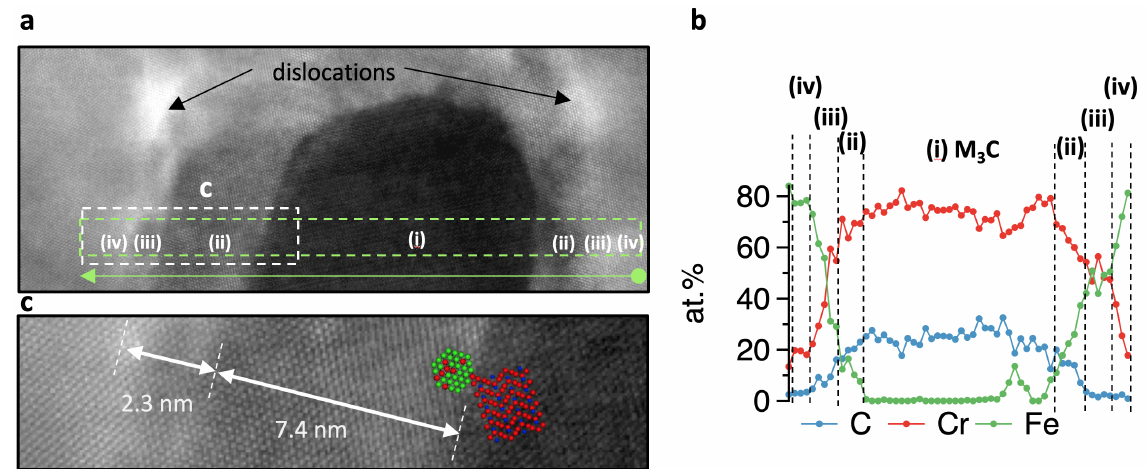
Figure 4. ( a ) The HR STEM magnification of Figure 3f with dislocations, ( i ) the carbide core, two clouds ( ii ), ( iii ) with different chemical compositions, and the Cr enriched bcc matrix ( iv ). The small highlighted area is shown magnified in ( c ), while the arrow with EELS at the bottom of ( a ) indicates the path of the plotted chemical line profile with EELS starting from right to left, shown in ( b